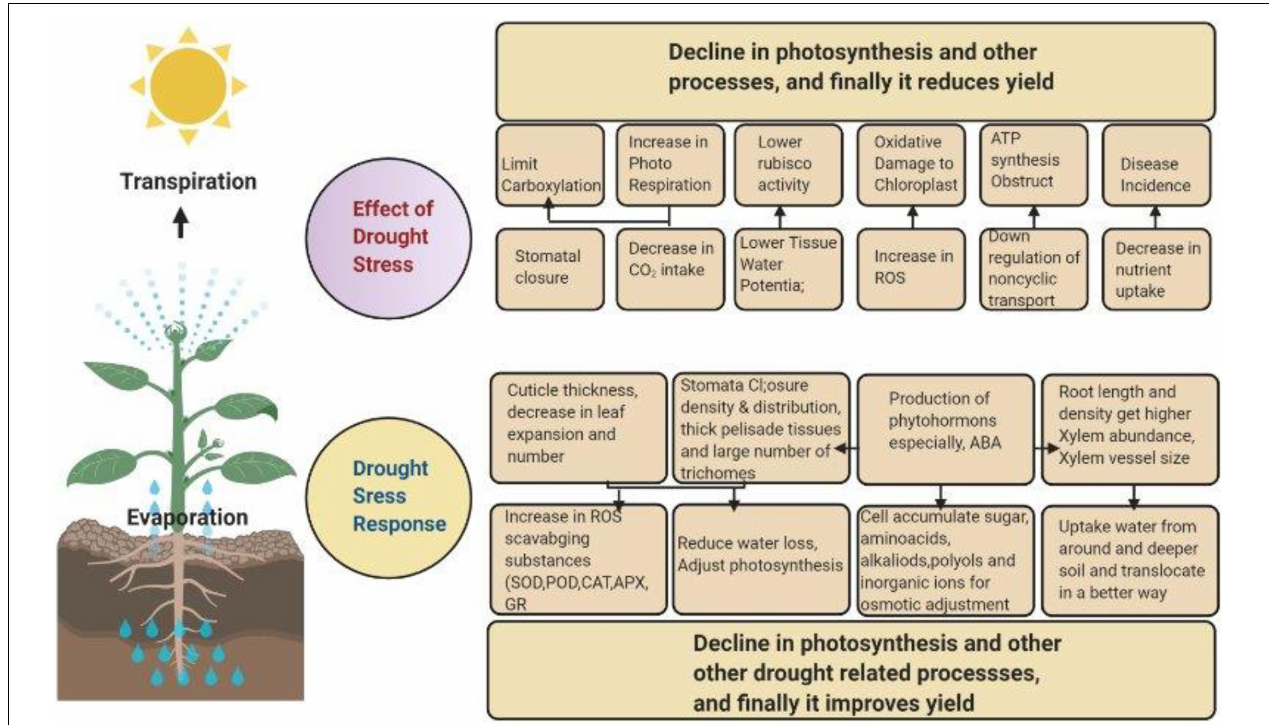
FIGURE 1 | Crop response, from physiological and morphological perspectives to drought stress. Drought stress affects the normal functioning of plants by lowering the rate of photosynthesis. To overcome this issue, plants increase the production of hormones and photosynthesis-related components as a defense